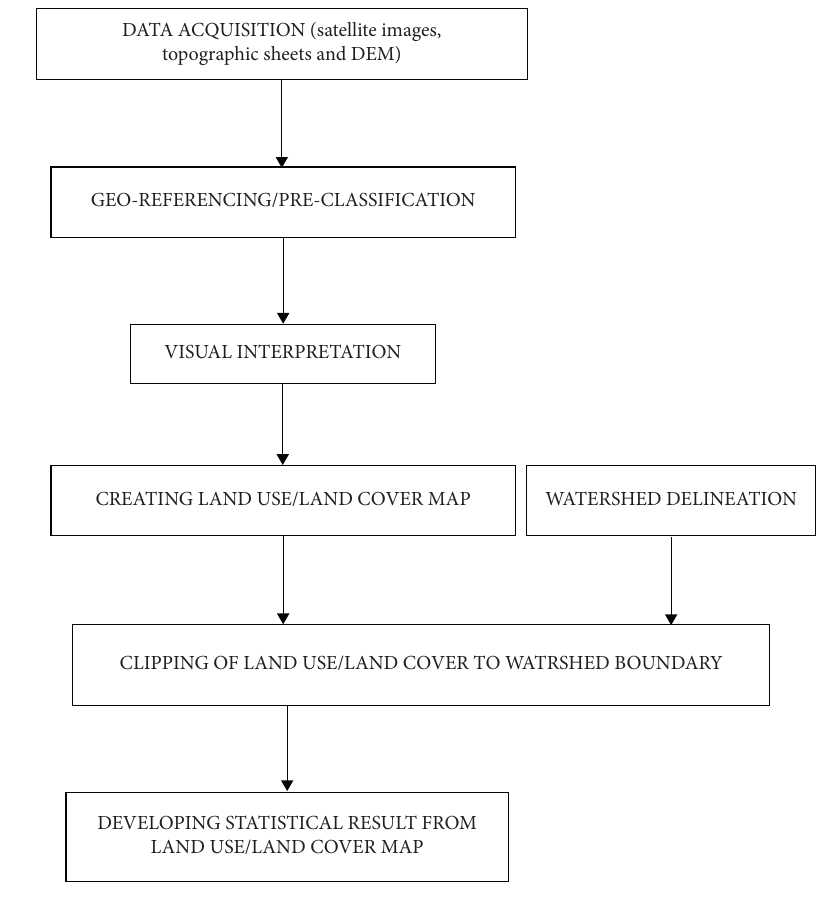
Figure 2: Flowchart of methodology. Table 1: Characteristics of the remotely sensed